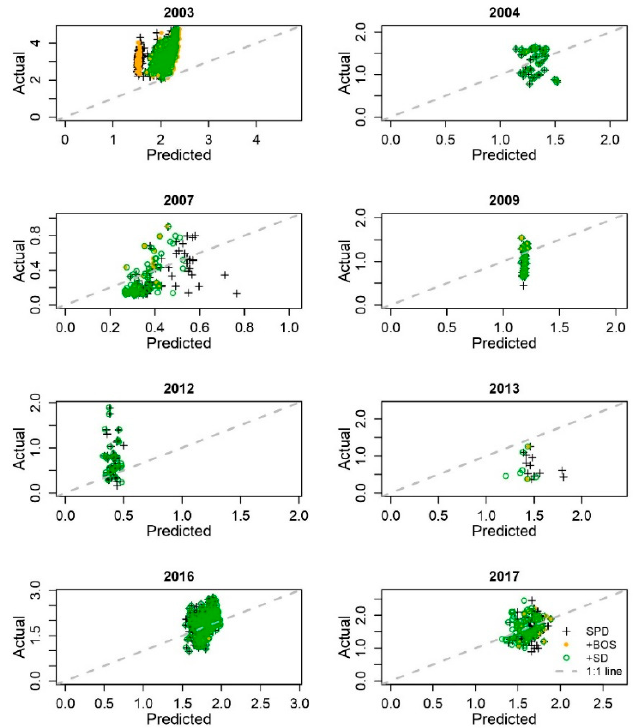
Figure 6. Scatterplots of actual and estimated yield for the pixels which had their estimated SOS date corrected from SPD to either +BOS or +SD.